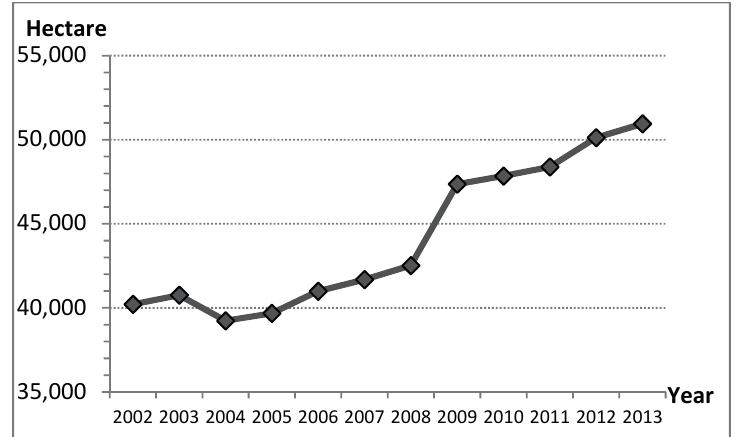
Figure 2. Trends for road areas construction, Taiwan’s cities, 2002 to 2013.